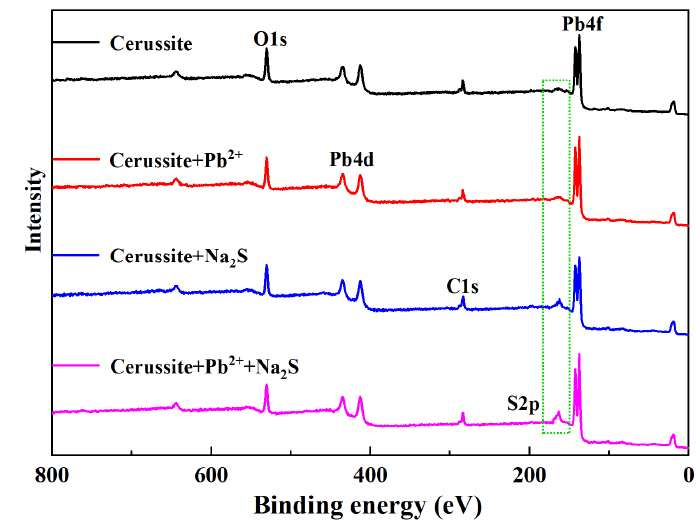
Figure 6. XPS survey spectra of cerussite .